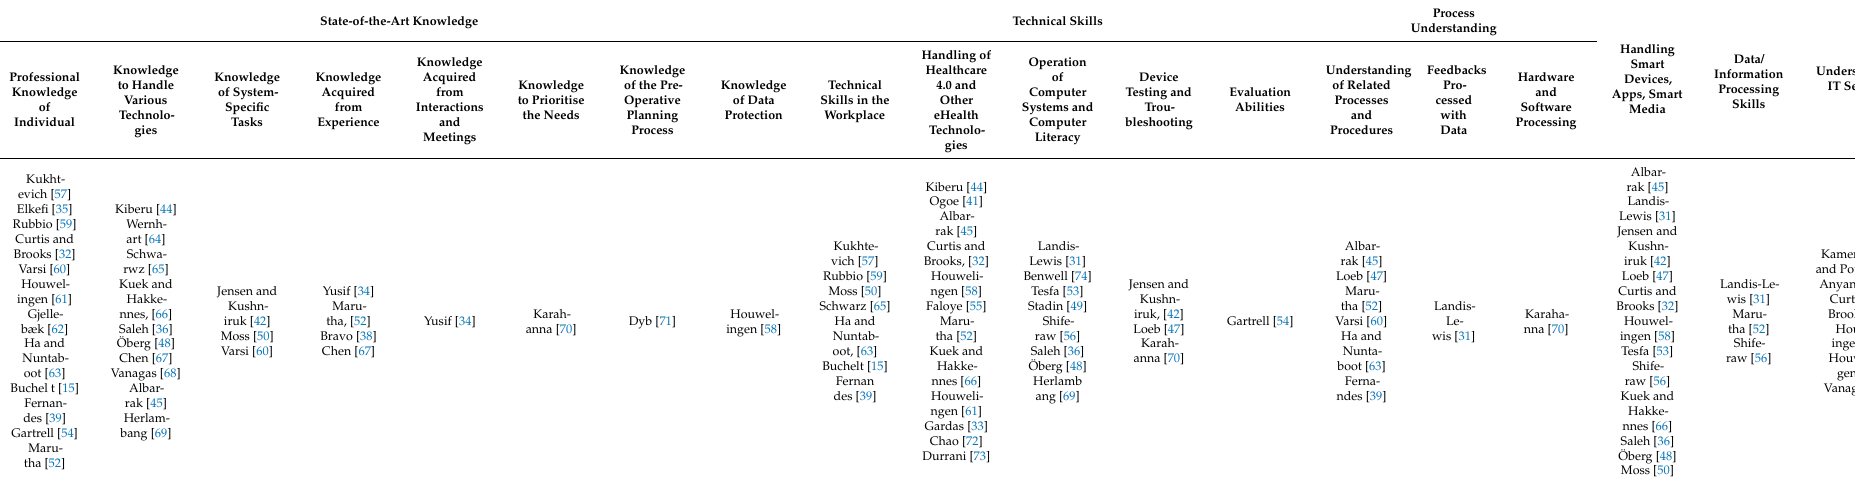
Table 7. Technical competence for adopting H4.0 ICTs and cited literature.